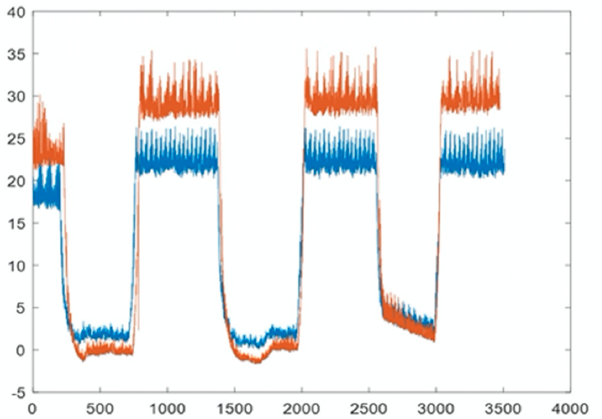
Figure 6. Relationship between the intravesical pressure detected by the pressure probe (brown) and PressureDot (blue) showing a with high correlation, R = 0.9498.